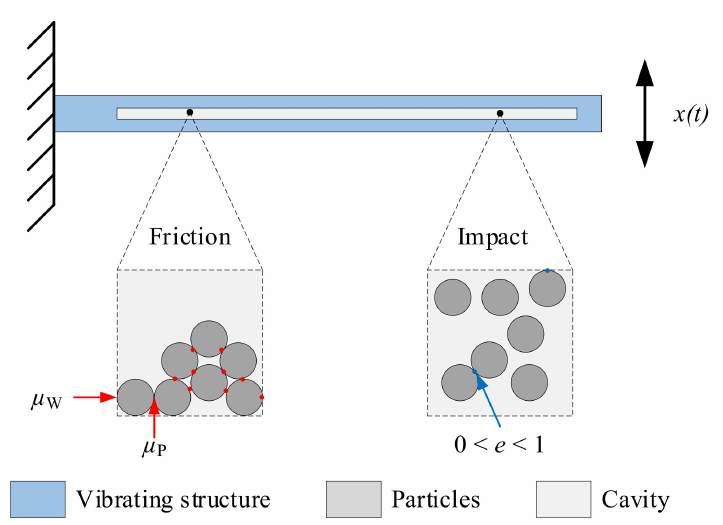
Figure 2. Schematic diagram of an additive manufactured particle damper, according to